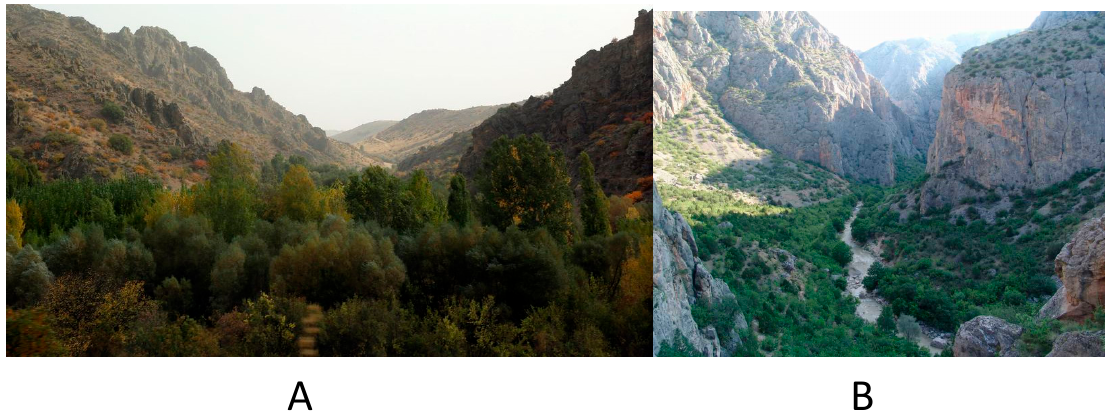
Figure 1. The habitat of terebinthus ( A ) Karanlıkdere region, ( B ) Kazankaya Canyon.